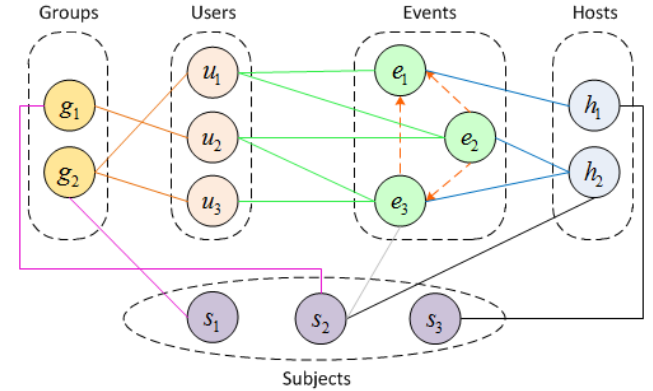
Figure 7. Illustration of hybrid graph